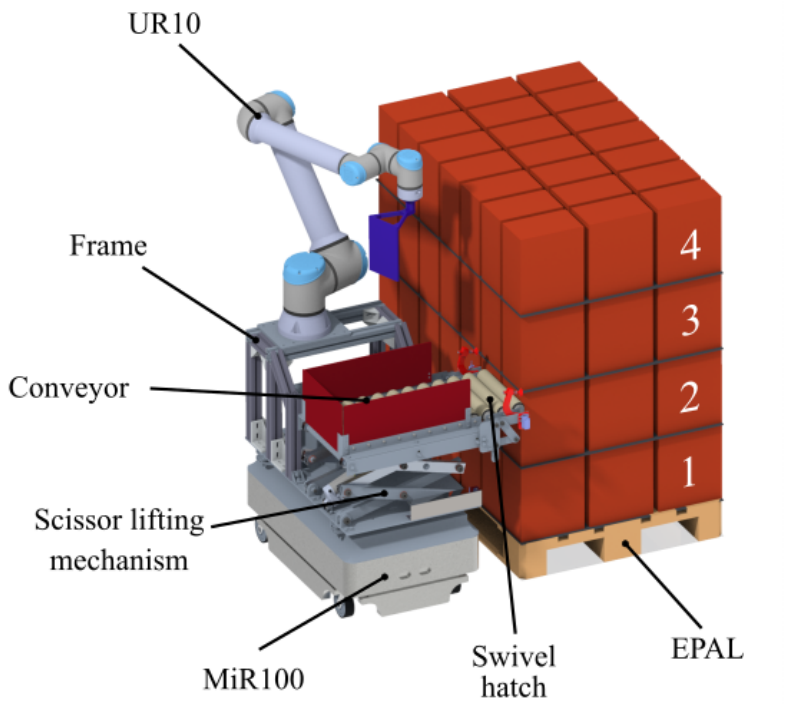
Figure 1. Overview of the mobile robot and its